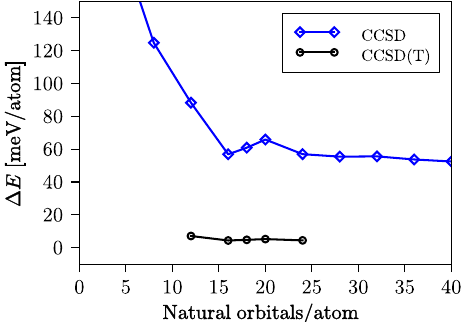
FIG. 2. Convergence of the energy difference between the carbon diamond and graphite using CCSD and 2 atomic unit cells with respect to the number of natural orbitals used. The (T) correlation energy contribution has been added to the CCSD energy using 16 natural orbitals per atom.